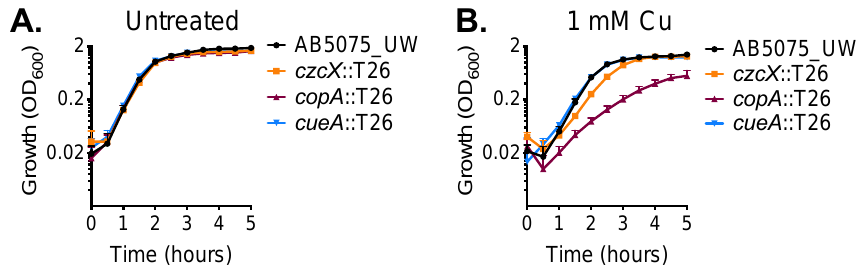
Figure 2. CopA is a contributor to copper resistance in A. baumannii . The growth of wild-type (WT) AB5075_UW cells (black) and the copA ::T26 (burgundy), cueA ::T26 (blue) and czcX ::T26 (orange) mutants was determined by measuring the optical density at 600 nm (OD 600 ) under ( A ) untreated conditions or ( B ) following supplementation of 1 mM CuSO 4 . The cultures were analysed at 37 ◦ C with shaking (600 rpm), with measurements taken every 30 min. The data represent the mean ( ± standard error of the mean [SEM]) of at least biological triplicates.